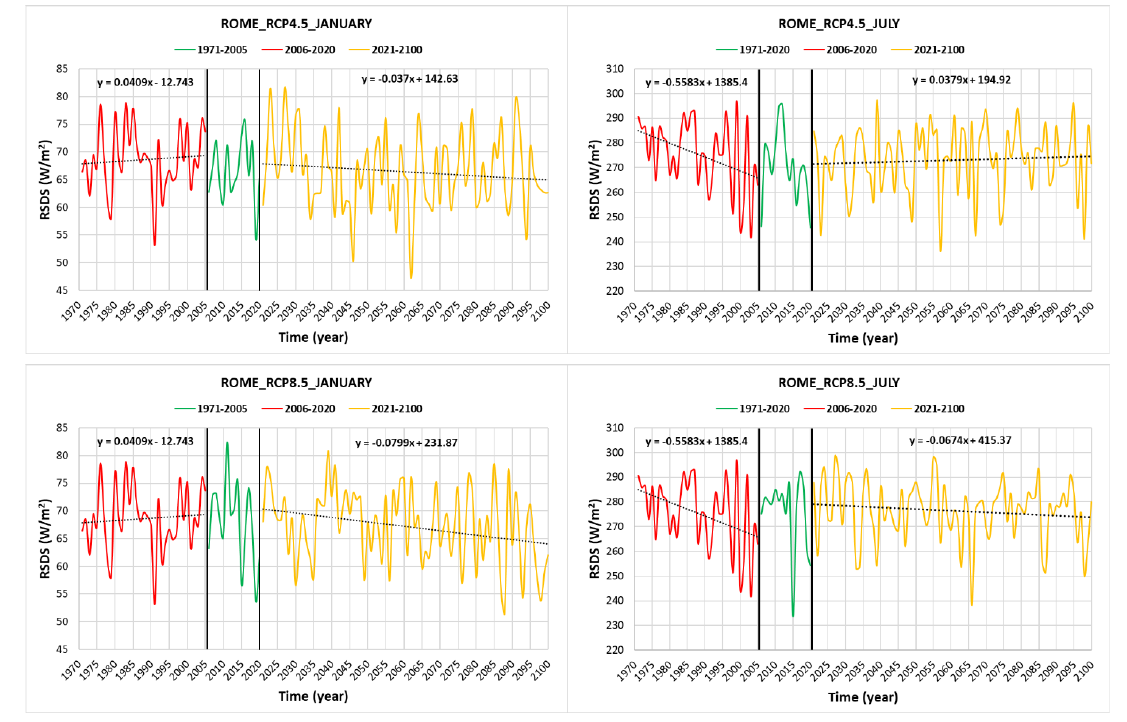
Figure 3. Rome’s monthly average hourly RSDS variation in January ( left ) and July ( right ) from 1971 to 2100. ( Top ): RCP4.5, ( bottom ): RCP8.5.